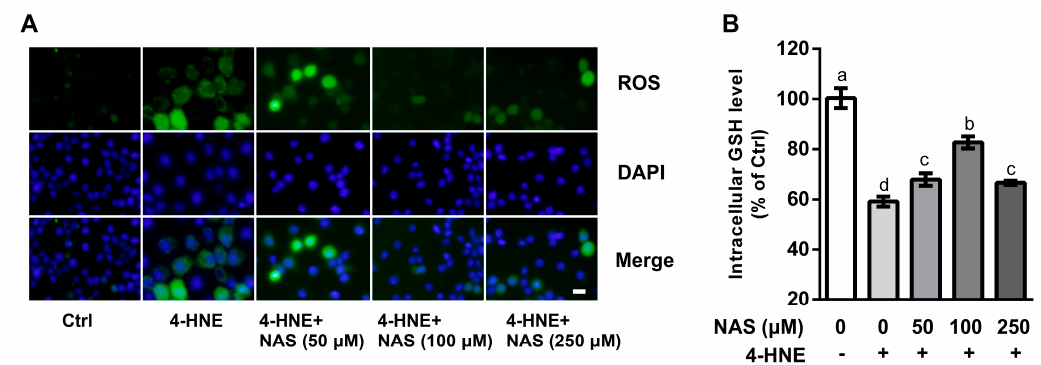
Figure 2. E ff ects of NAS on reactive oxygen species (ROS) and intracellular glutathione (GSH). Cells were left untreated or treated with 4-HNE in the absence or presence of NAS administration as indicated. ( A ) ROS were determined and visualized by a fluorescence microscope, magnification × 100. ( B ) intracellular GSH concentrations were measured. Representative results from three independent experiments were provided, and values are means ± SEMs, n = 3. Means without a common letter di ff er, P < 0.05.